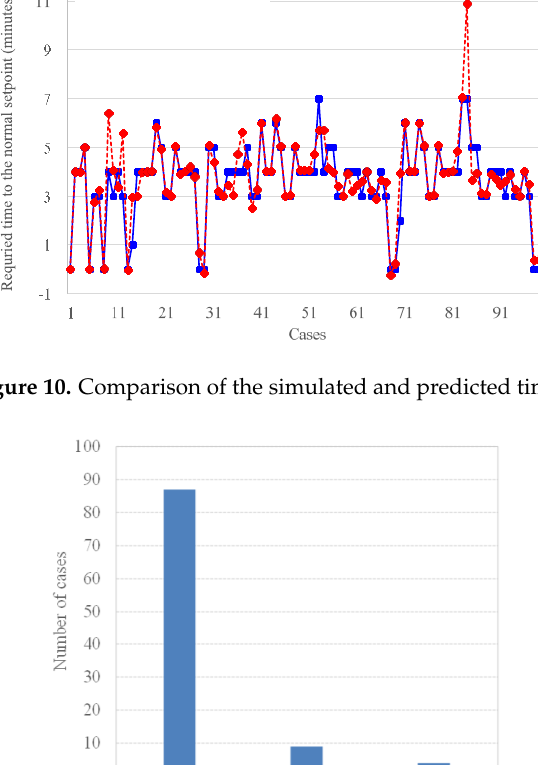
Figure 11. Number of cases according to the amount of difference.